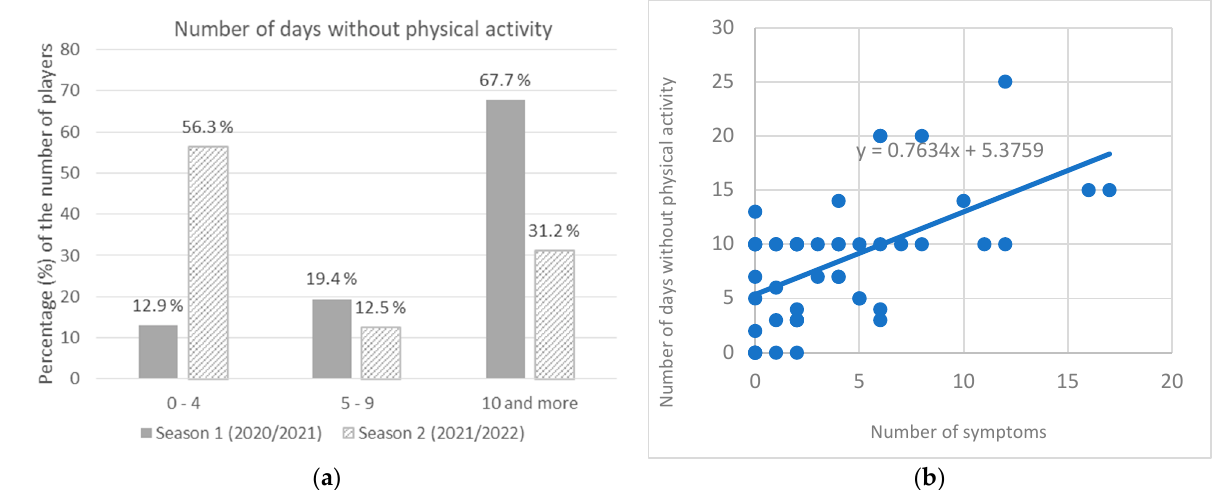
Figure 3. ( a ) Number of days with no physical activity among infected players; ( b ) Correlation of number of symptoms and number of days with no physical activity.